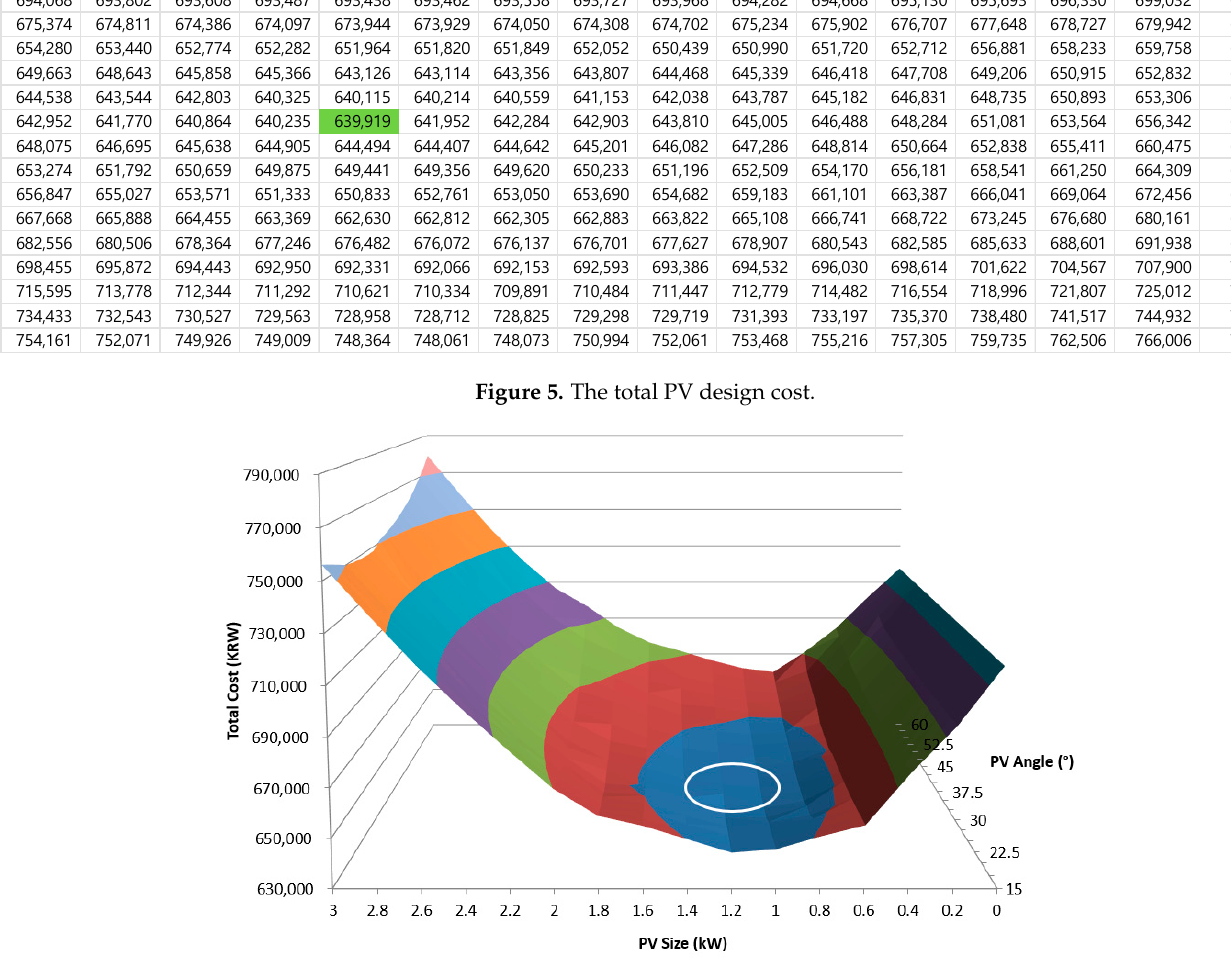
Figure 6. Map of the total PV design cost.